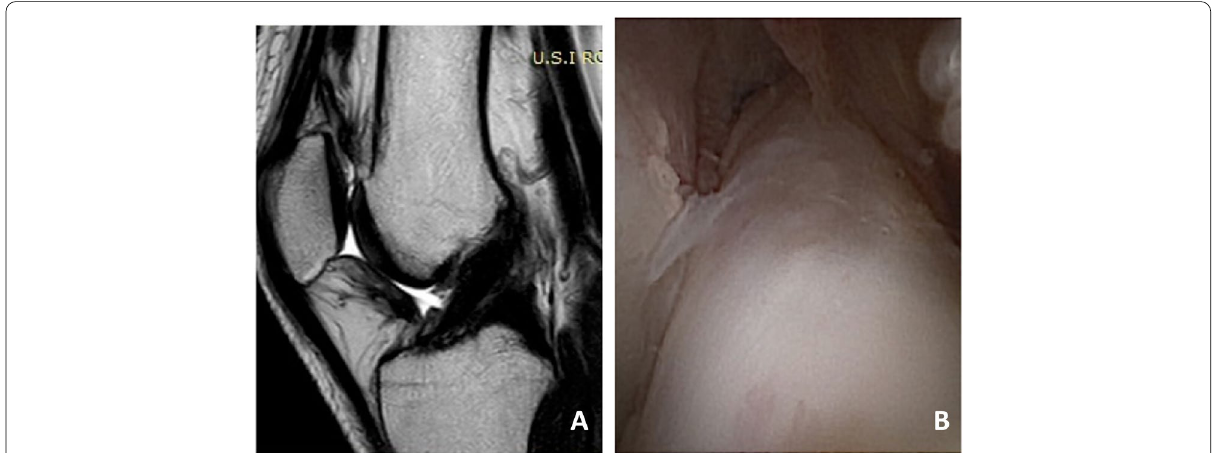
Fig. 1 ACL repair. A Sagittal T2-TSE MRI post-operative 6 months after ACL repair (Howell I); B In-office needle arthroscopic view of the repaired ACL of the same patient showing type A healing